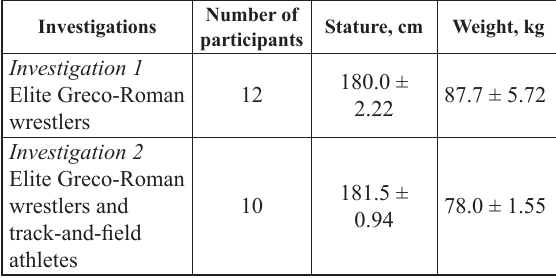
Table 1. Characteristics of the subjects Investigations